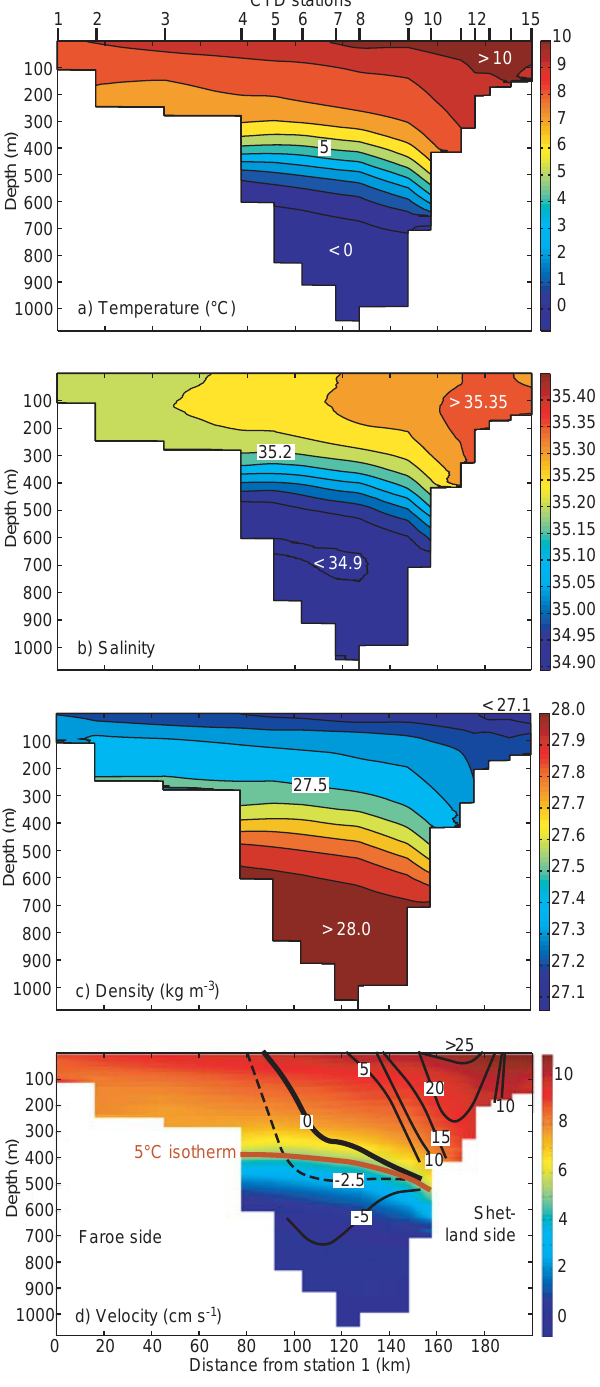
Fig. 4. Averages for the period 1995–2009 of temperature (a) , salin- ity (b) , density ( σ t ) (c) , and along-channel velocity superposed on the average temperature distribution (d) . The velocities are based on geostrophy from CTD data corrected with altimetry-adjusted veloc- ity data using the core interpolation. The average depth of the 5 ◦ C isotherm along the section is indicated by the brown line on (d)